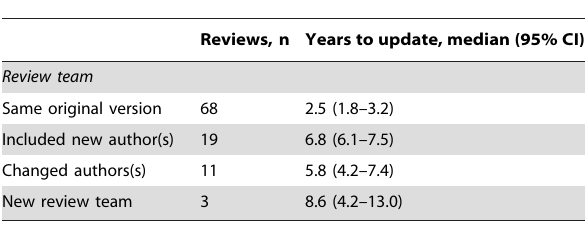
Table 3. Time to first update of the 101 updated reviews, by review team.